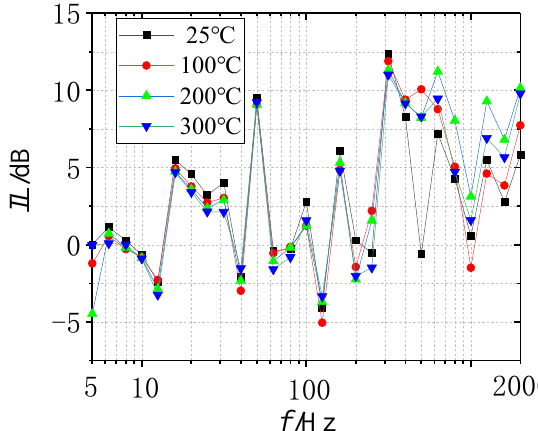
Figure 17. Insertion loss octave curves of pipeline at different ambient temperatures.